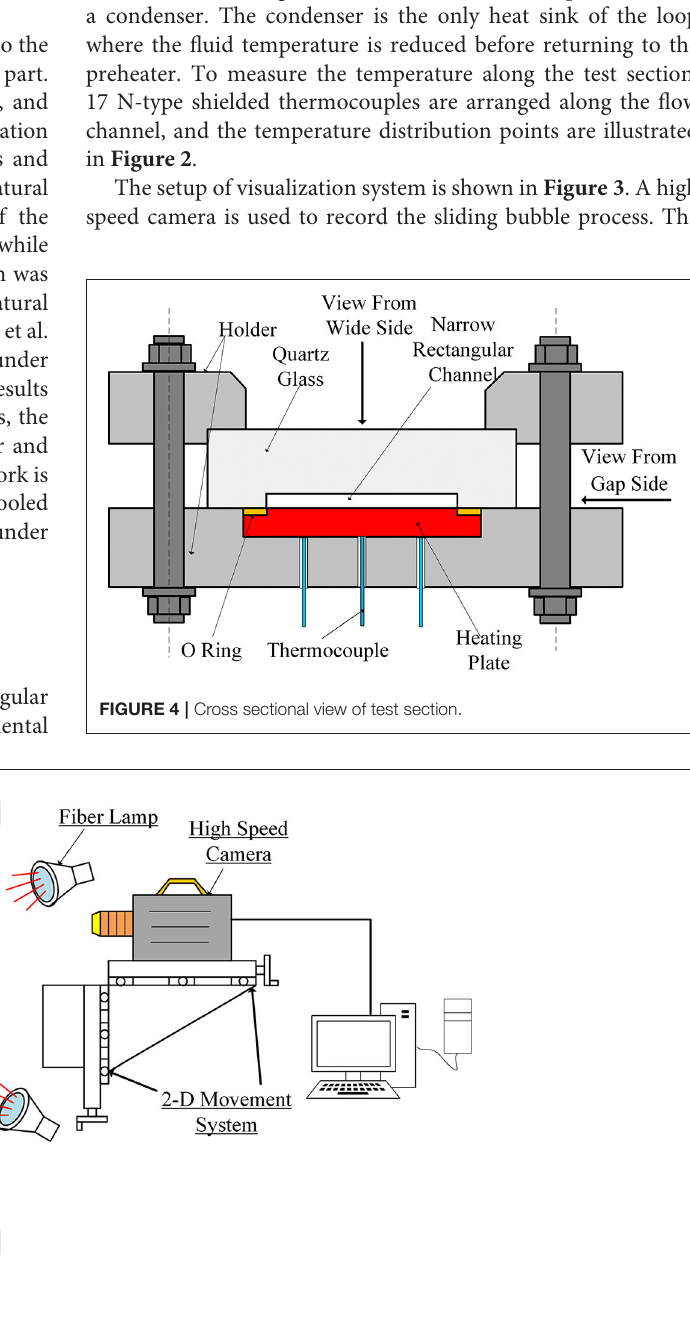
FIGURE 3 | Schematic of visualization